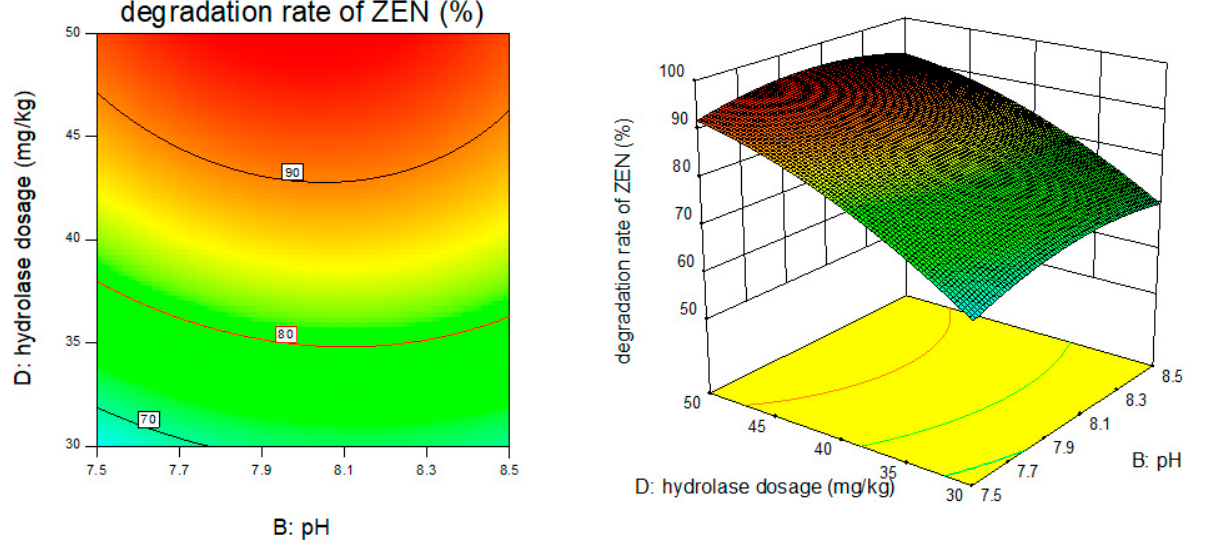
Figure 9. PH, enzyme dosage, and their interaction vs. the response surface and contour line of the degradation rate of ZEN.